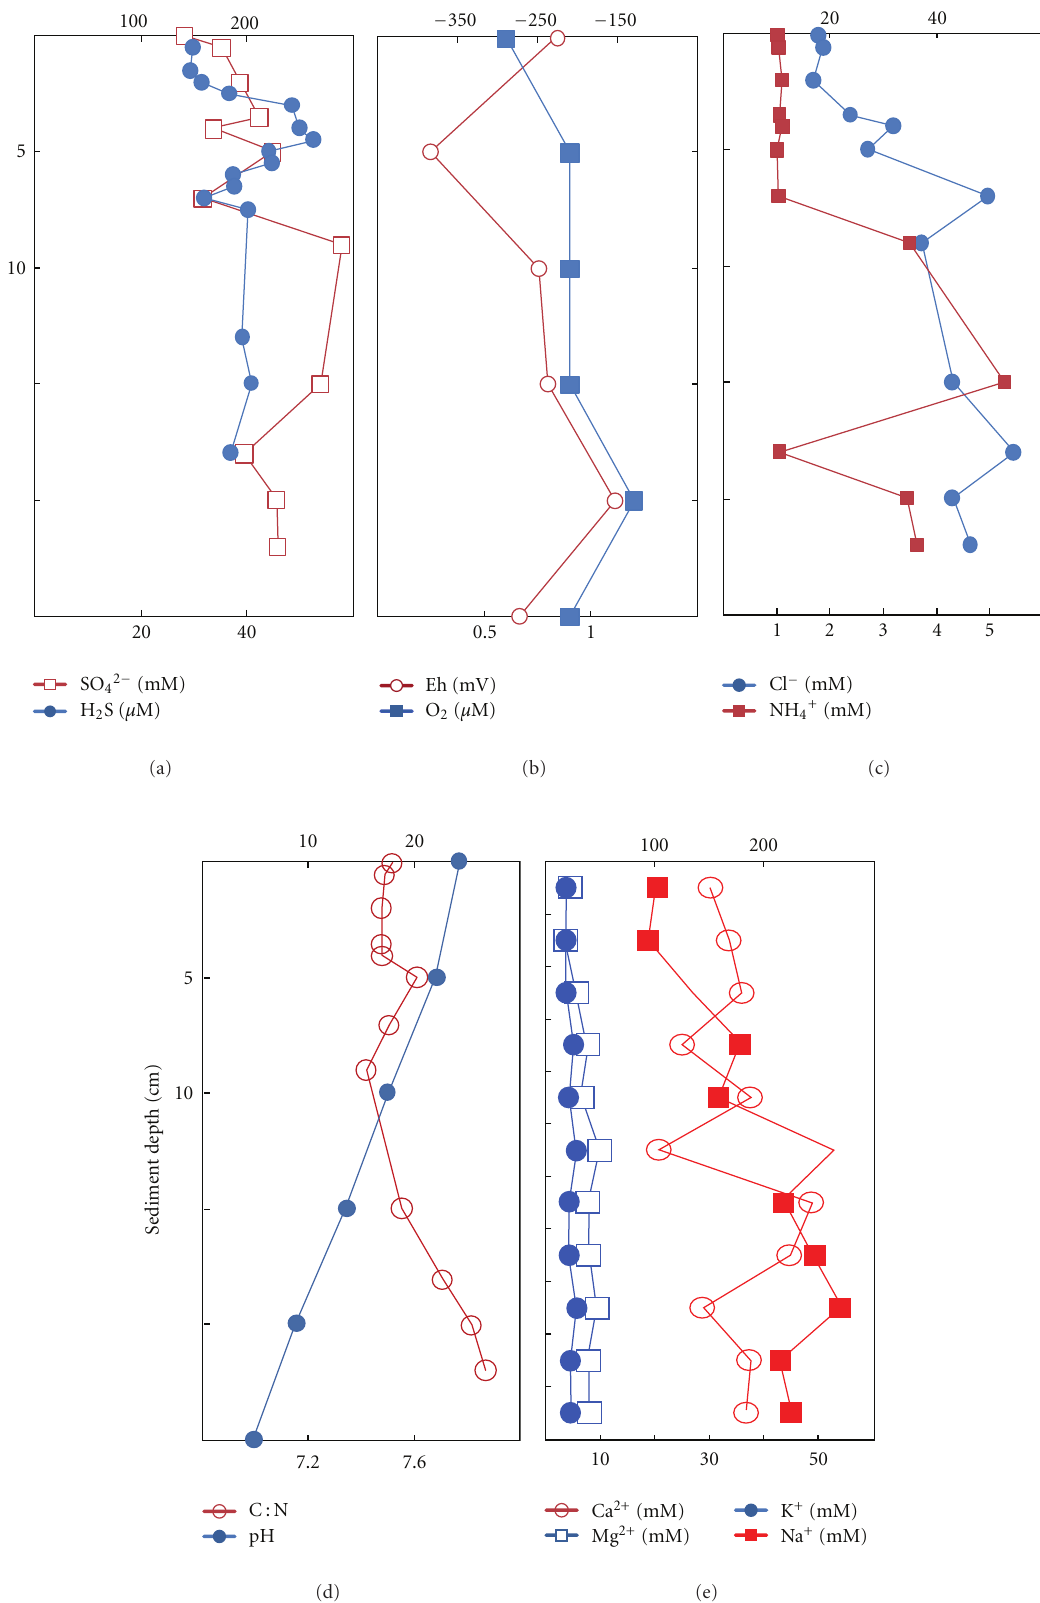
Figure 1: Profiles plotting depth against physicochemical parameters measured in Tirez sediments from winter cores. (a) Sulfide and sulfate; (b) Redox potential (Eh) and oxygen; (c) chloride and ammonium; (d) pH and C:N ratio; (e) magnesium, calcium, potassium, and